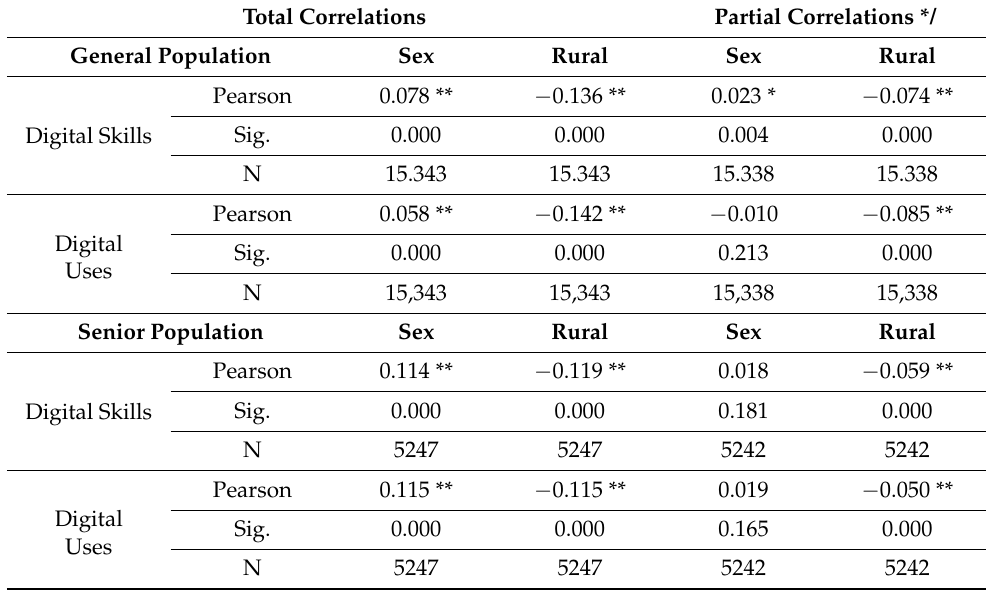
Table 8. Partial correlation effects between sex, rural and digitalization. Total Correlations Partial Correlations */ General Population Sex Rural Sex Rural Pearson 0.078 ** − 0.136 Digital Skills